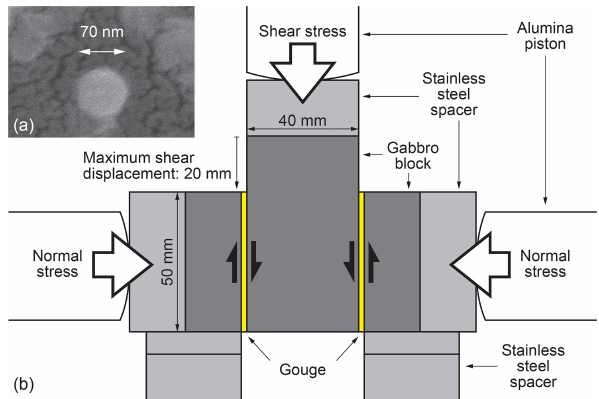
Figure 1. (a) SEM micrograph of synthetic brucite used in this study. (b) Schematic view of the biaxial testing machine used in this